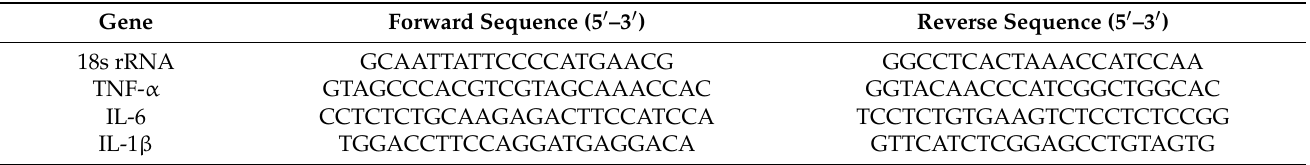
Table 2. List of primers used for the quantitative polymerase chain reaction (qPCR). Gene Forward Sequence (5 (cid:48) –3 (cid:48) ) Reverse Sequence (5 (cid:48) –3 (cid:48)